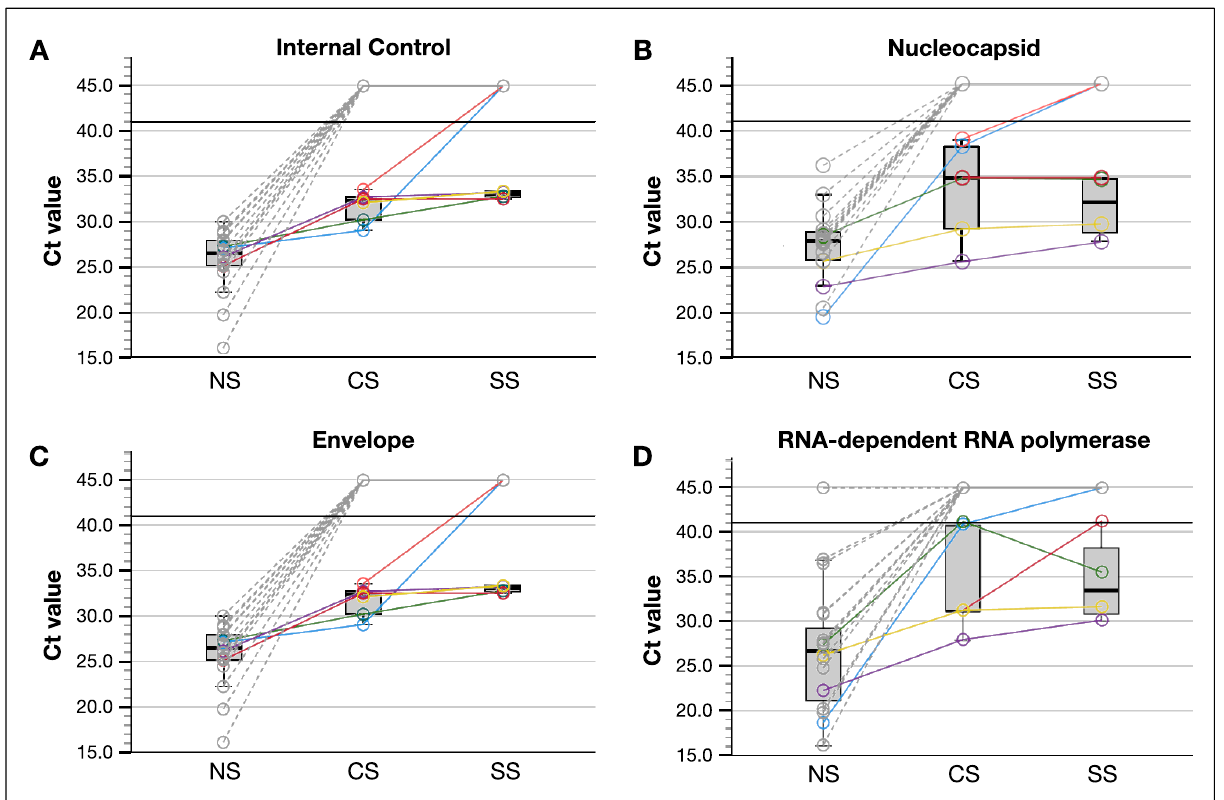
Figure 2. Nasopharyngeal swabs had lower cycle threshold values than tear samples. ( A ) Internal control. ( B ) Nucleocapsid. ( C ) Envelope. ( D ) RNA-Dependent RNA Polymerase. Colored and grey lines represent, respectively, patients with a positive and negative detection of SARS-CoV-2 in tear samples, each different colored line represent the same patient. Black line shows the cut off value for test positivity. Each dot corresponds to one patient. CS: conjunctival swab; E: envelope; IC: internal control; N: nucleocapsid; Na: nasopharynges; RdRp: RNA-dependent RNA polymerase; SS: Schirmer strip.